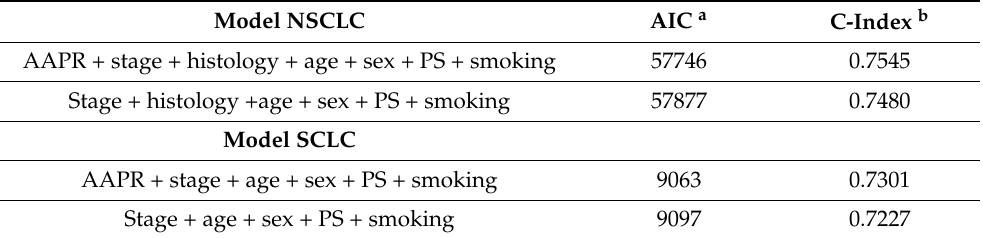
Table 3. Predictive accuracies of the prognostic models.